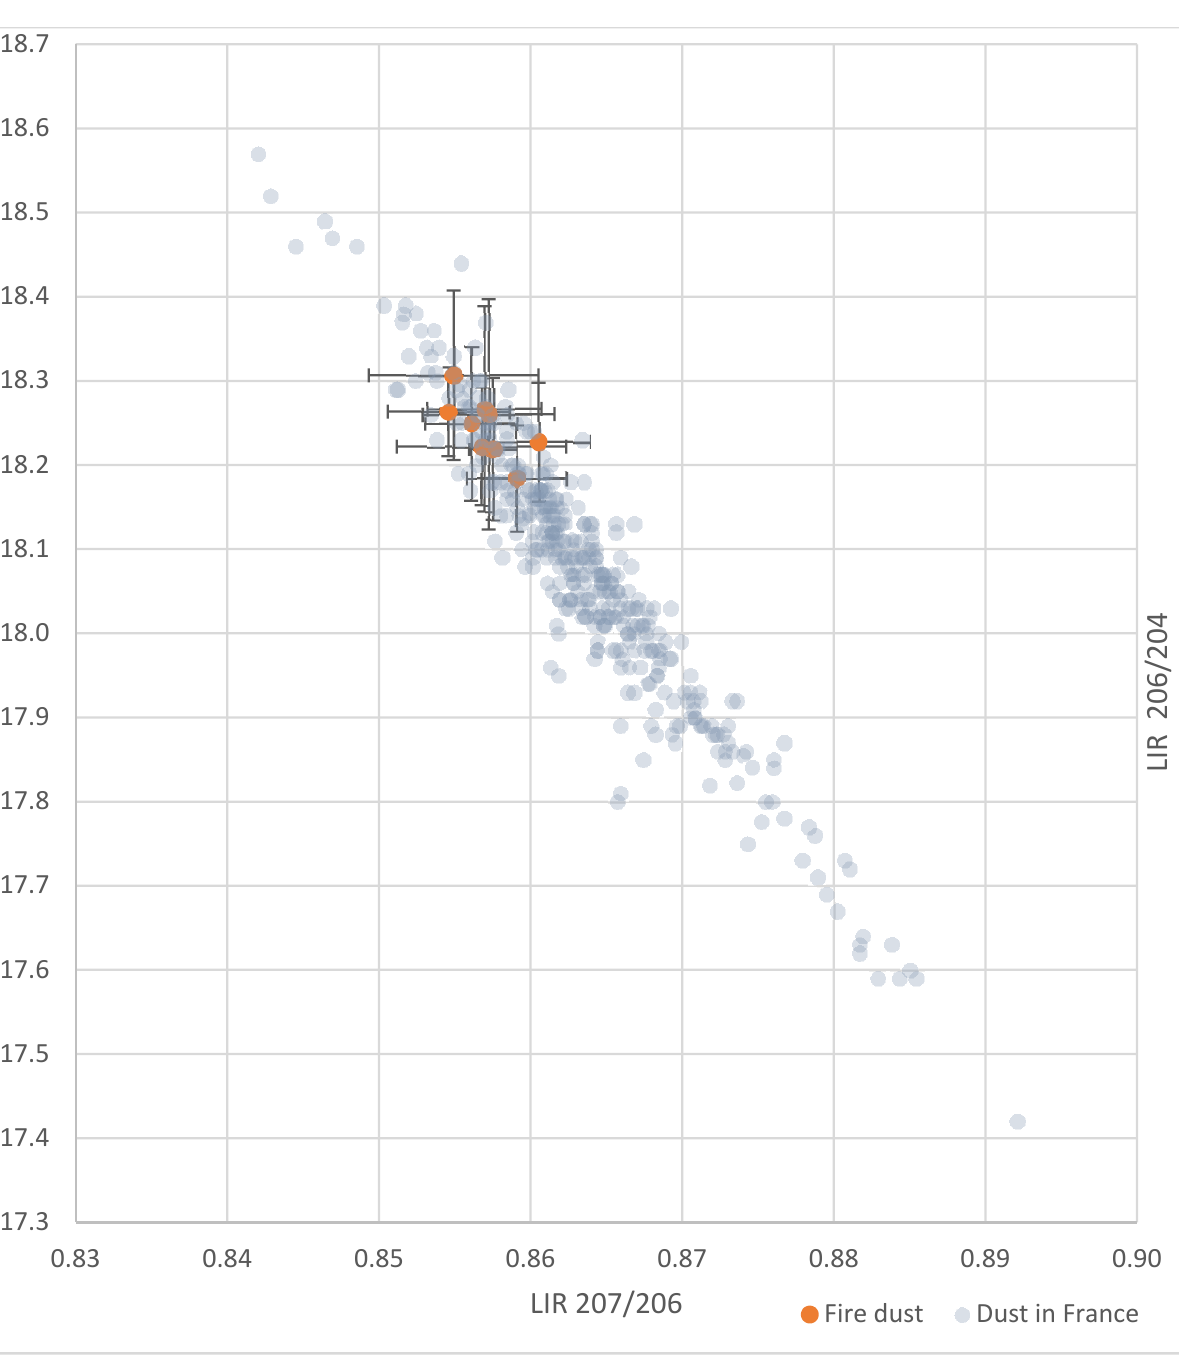
Figure 3. Lead isotopic ratios of Notre Dame de Paris cathedral fire dust and home dust in France. Figure 4 shows the lead isotopic ratios of cathedral dust samples and those of blood from young children living in France in 2008–2009 [9]. It indicates that the dust IRs overlap with several lead IRs that were measured 10 years before the fire, in similar sampling and IR determination